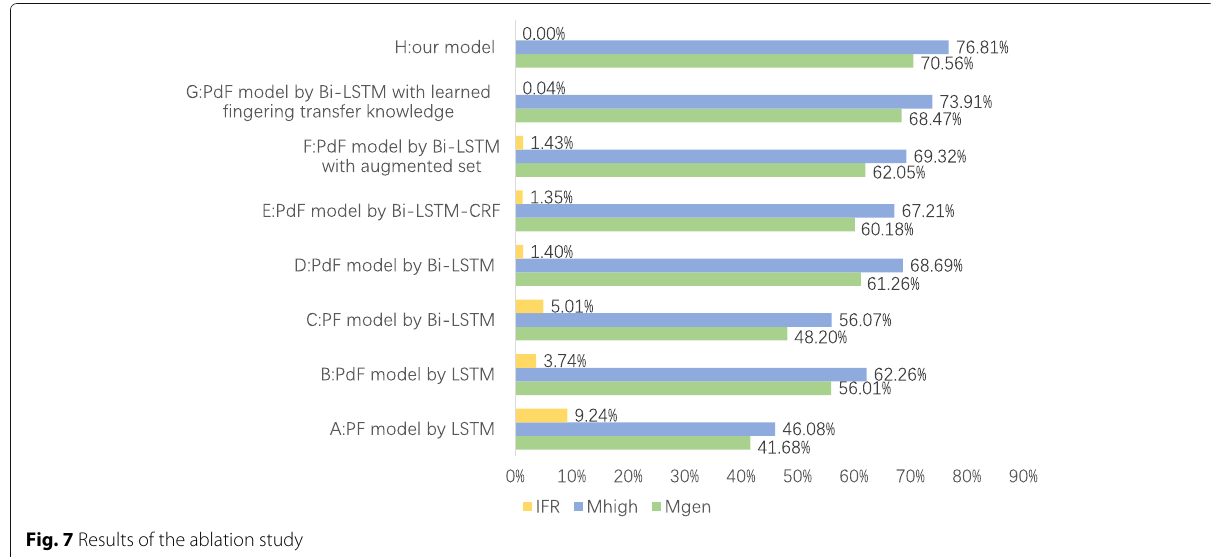
Fig. 7 Results of the ablation